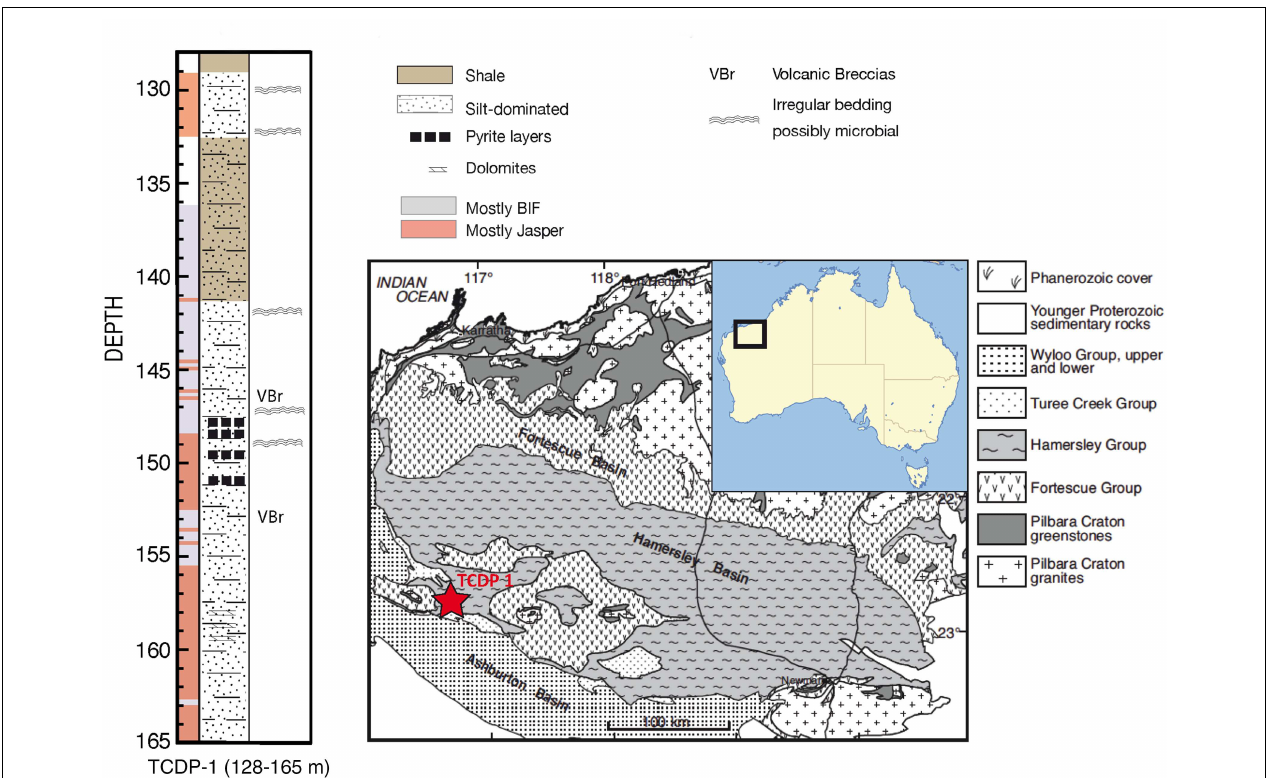
FIGURE 1 | Regional geological map of the Pilbara area in Northwest Australia (after van Kranendonk et al., 2015) and simplified lithology of the TCDP-1 core between 128 and 165m depth. The red star localizes the drilling.